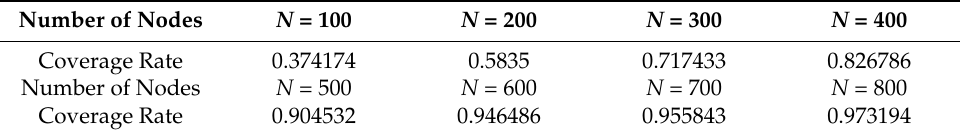
Table 3. Network coverage rate (200 m ˆ 200 m).